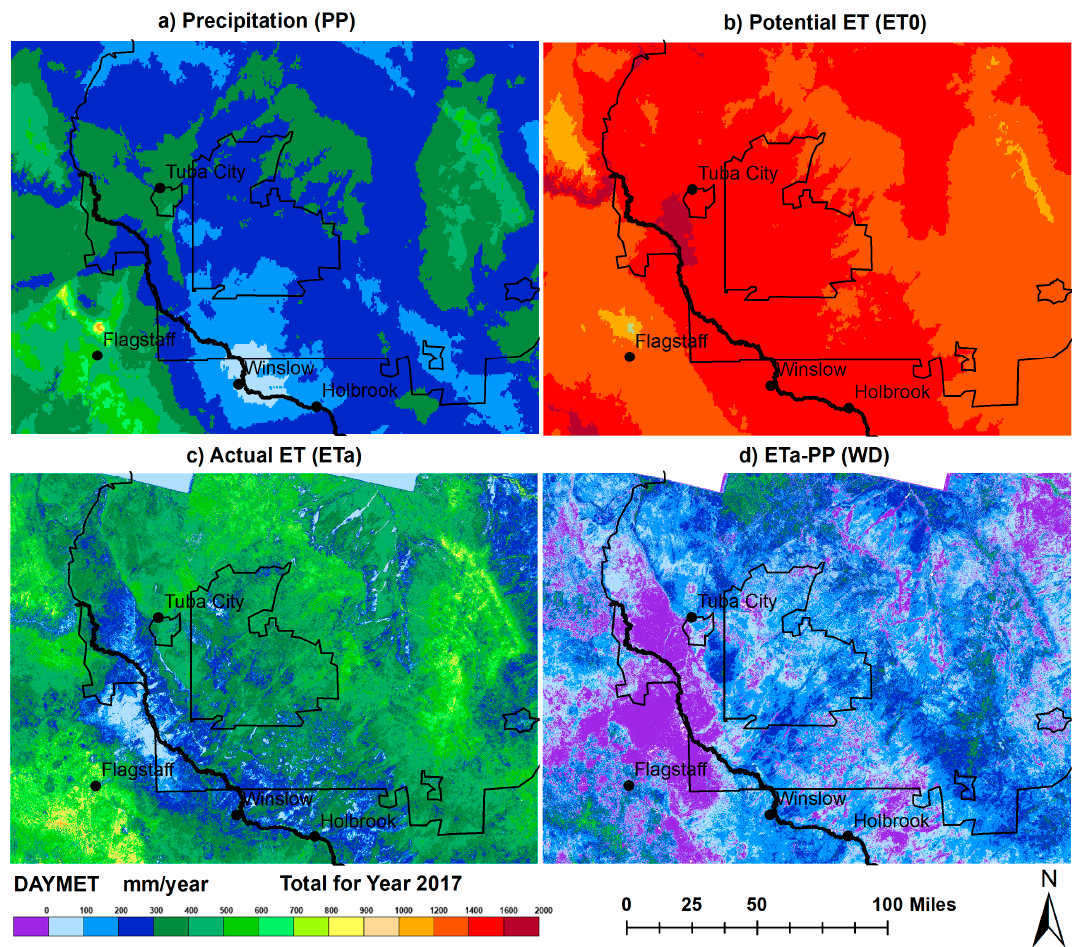
Figure 7. Annual water metrics (( a ) precipitation (PP), ( b ) potential ET (ETo), ( c ) actual ET (ETa) and ( d ) net water requirement or ETa ‐ PP (WD)) for 2017 using weather data from Daymet (gridded 1 km) and produced at Landsat 30 m resolution for northeast Arizona.